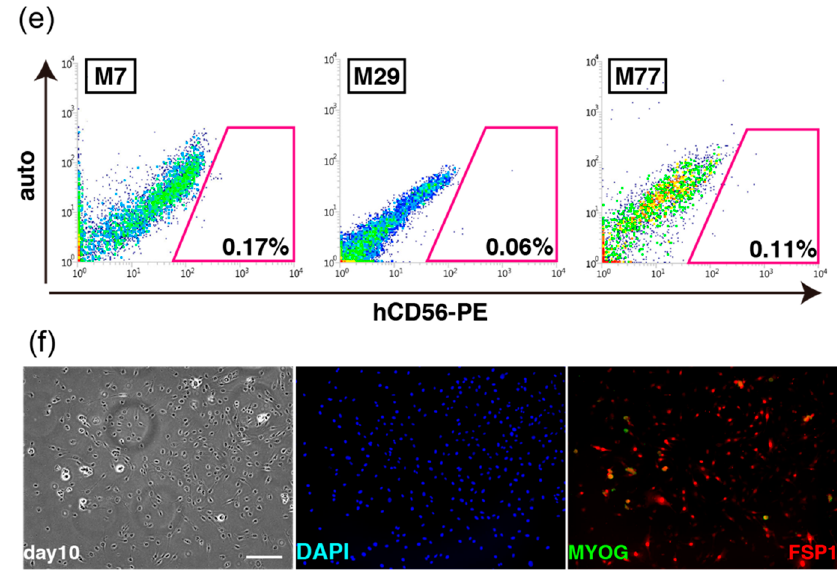
Figure 1. Characteristics of surgically obtained eyelid tissues and cells. ( a ) Isolated eyelid tissues were immunostained with anti-DYSTROPHIN (DYS, green) and laminin α -2 (LAMA2, red) antibodies. Scale bar, 50 μ m. ( b ) Transverse section of isolated tissues containing myofibers, stained with anti-DYS (green). Scale bar, 50 μ m. ( c ) Sagittal section of ( b ). Scale bar, 50 μ m. ( d ) Single myofibers from extra eyelid tissues were immunostained with anti-PAX7 (arrowhead, green in right panel), and DMD (red). Scale bar, 100 μ m. ( e ) FACS profiles for detecting CD56-positive cells from digested eyelid tissues. Samples from M7 (a 7-year-old male patient), M29 (a 29-year-old male patient), and M77 (a 77-year-old male patient) were analyzed. ( f ) Morphology of cultured cells from digested eyelid tissues over 10 days (left panel). Expanded cells were immunostained with anti-MYOGENIN (MYOG, green) and anti-FSP1 (red). Scale bar, 100 μ m. All nuclei were stained with 4’6-diamidino-2-phenylindole (DAPI, blue). For dissociating single human myogenic cells, we used extra eyelid tissues obtained from blepharoptosis or corrective strabismus surgery (left and middle panels in Figure 2a). Adipocytes (arrowheads, left panel in Figure 2b), blood capillaries (arrowheads, middle panel in Figure 2b), and myofibers (arrowheads, right panel in Figure 2b) were observed in the extra eyelid tissues obtained from the patients. These tissues were mechanically dissected (right panel in Figure 2a), enzymatically dissociated, and filtrated into single cells (Figure 2c). These cells from extra human eyelid biopsies were placed on Geltrex-coated dishes and cultured in DMEM containing 20% fetal bovine serum and basic